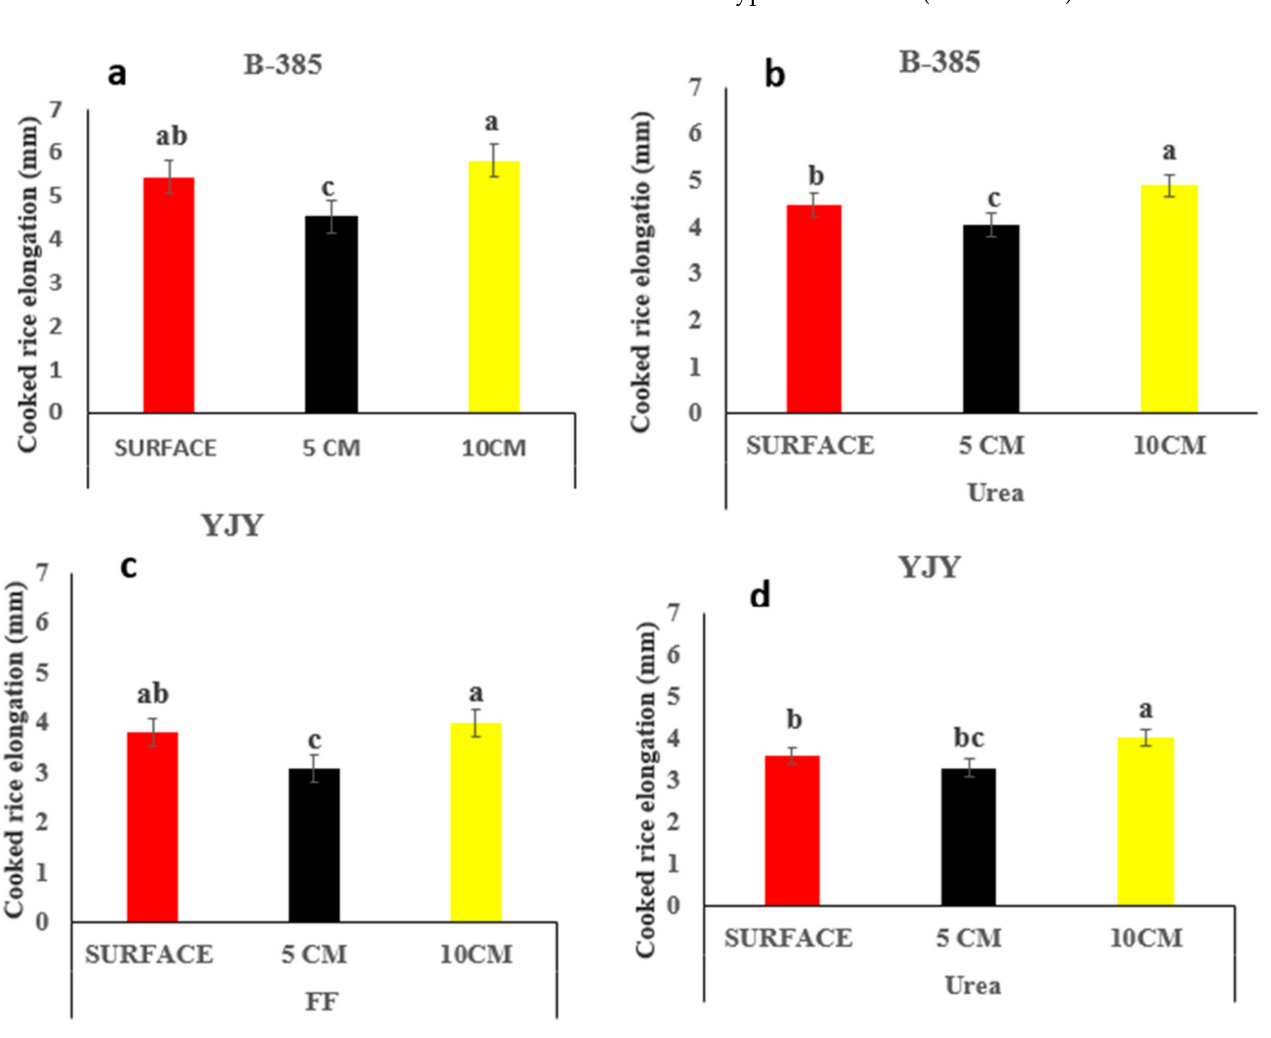
Figure 2. The effects of fertilizer application on cooked rice elongation in the grains of B-385 and YJY: ( a ) B-385 cooked rice elongation under different applications of FF; ( b ) B-385 cooked rice elongation under different applications of Urea; ( c ) YJY cooked rice elongation under different applications of FF; ( d ) YJY cooked rice elongation under different applications of Urea. (a, b, c, ab, cb) on each barre indicate significant differences among different treatments p < 0.05 within a